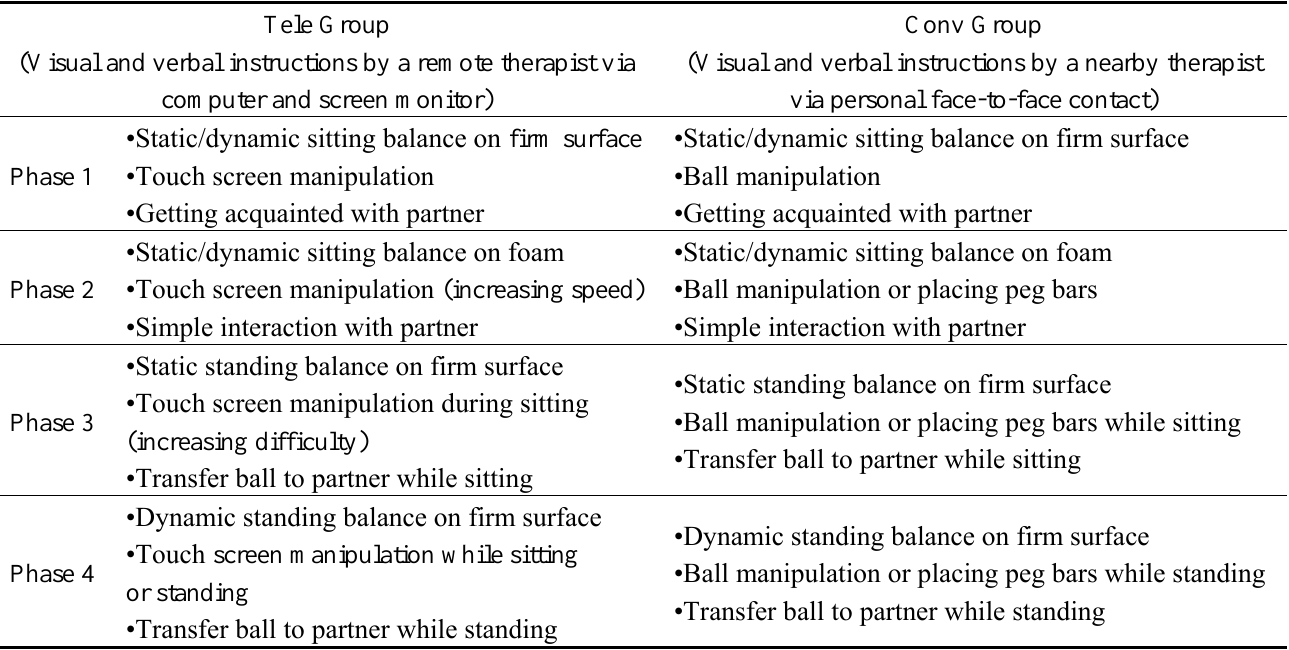
Table A1. General principle of programs for progression.